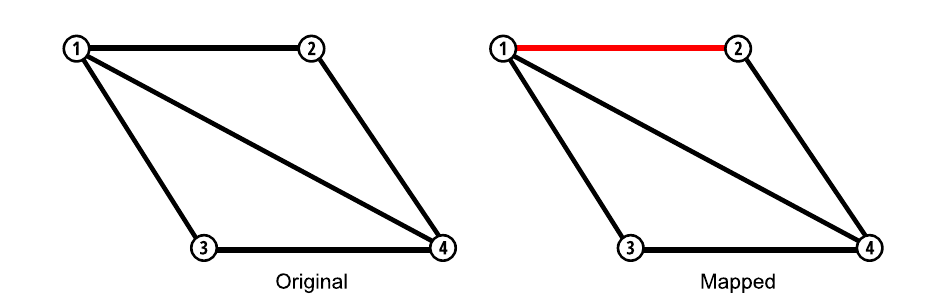
Figure 2. Mapped